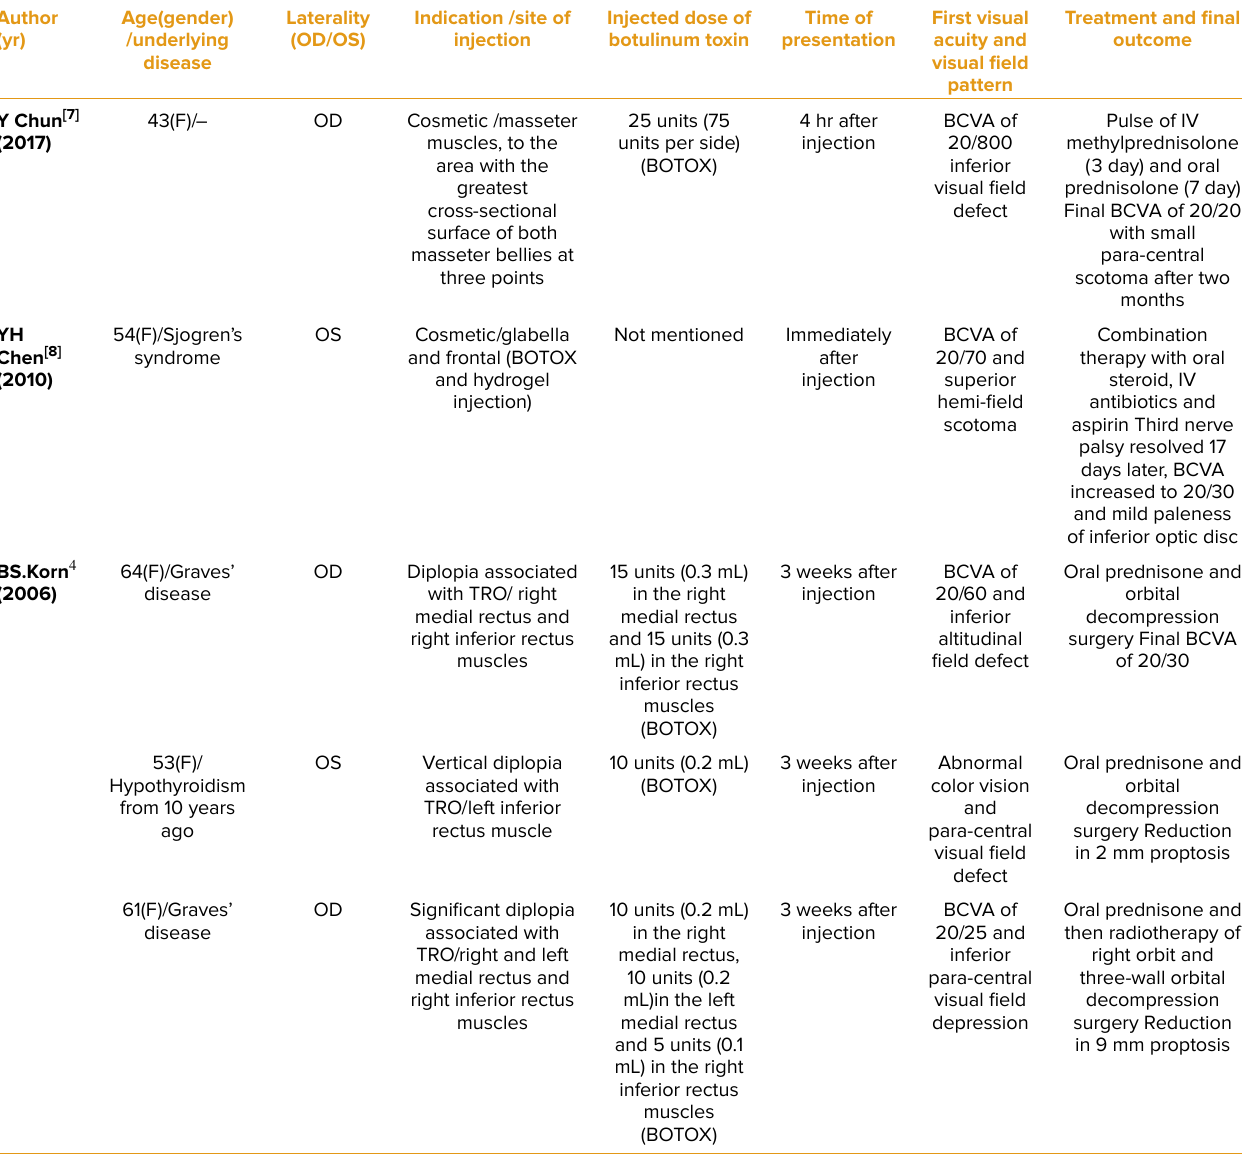
Table 1. Data of previous case reports of botulinum toxin-induced